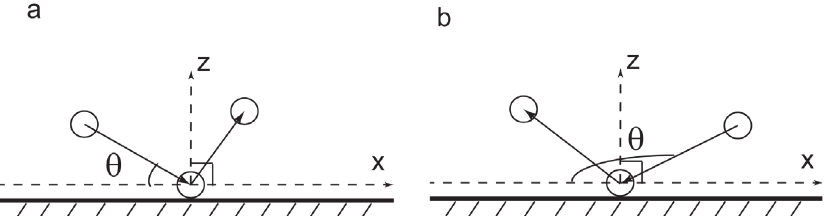
Figure 1. A sketch of incident angle. x and z represent the stream-wise and the vertical direction, respectively. h is the incident angle. (a) shows the case of h M [0 u ,90 u ) and (b) tells the case of h M [90 u ,180 u ].